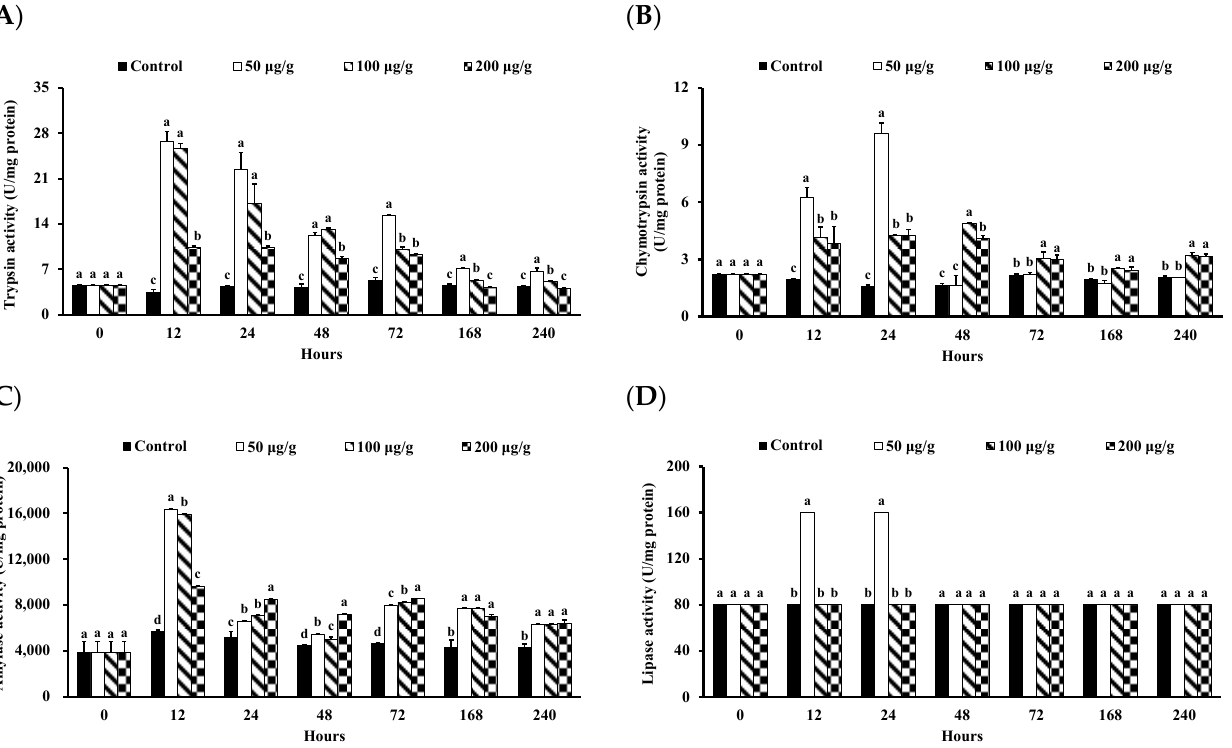
Figure 5. Trypsin ( A ), chymotrypsin ( B ), amylase ( C ), and Lipase ( D ) activity of Litopenaeus vannamei that received the water extract of Panax notoginseng at 50, 100, and 200 µ g (g shrimp) − 1 and control shrimp. Data are expressed as mean ± SD ( n = 8). Different superscript letters indicate that the same exposure time significantly differs ( p < 0.05) among groups (Duncan’s multiple range tests).